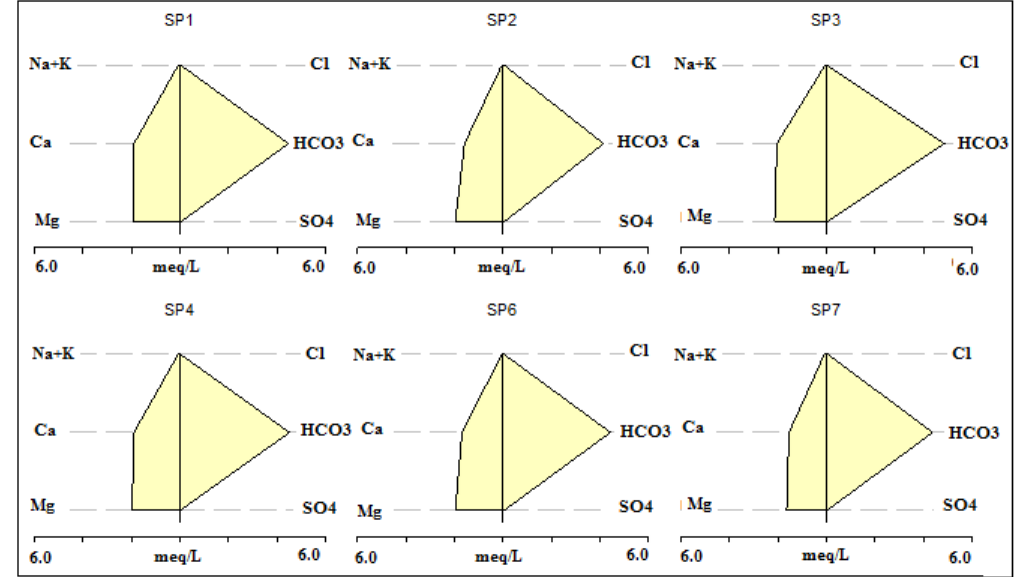
Figure 10. Stiff diagrams showing hydrochemistry of the dolomitic springs.